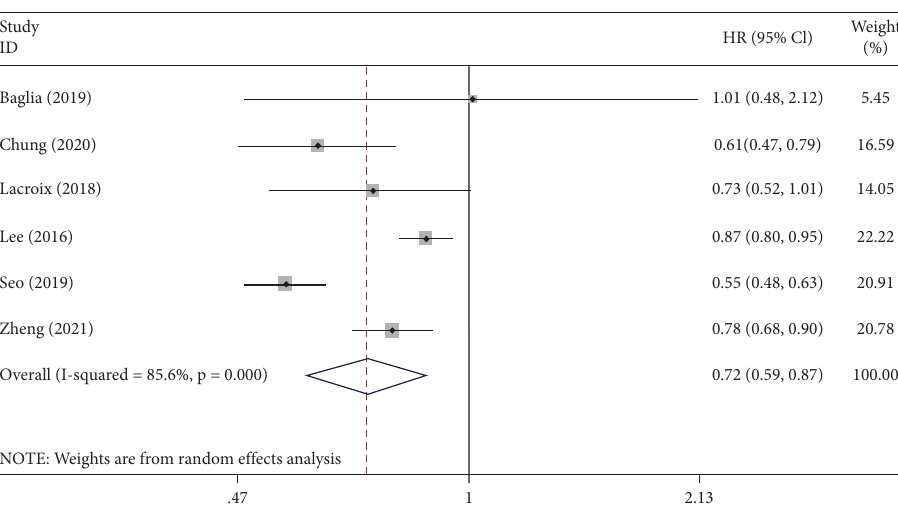
Figure 2: Forest plot of the overall survival (OS) of GC patients with T2DM after exposure to metformin ( p � 0.001).